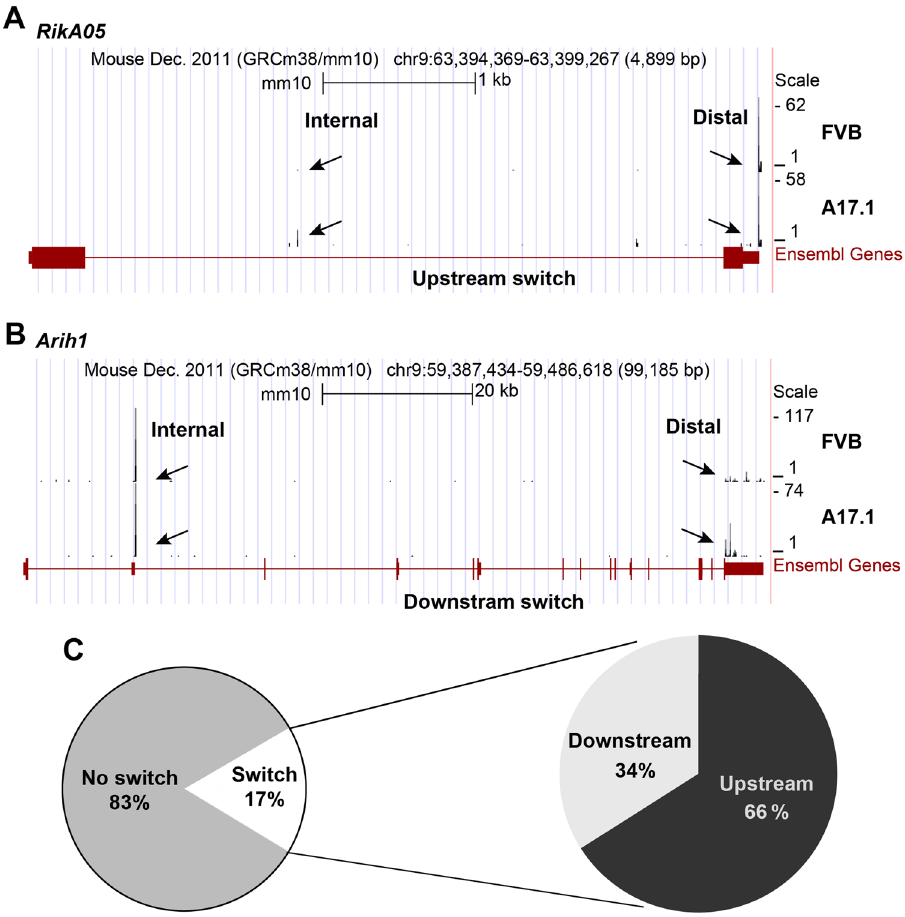
at each PAS. One of the FVB control and A17.1 mice are depicted in independent traces. PASs are depicted by arrows ; distal or internal PASs are indicated. The gene structure based on Ensembl annotation is presented in red . The ampli fi ed regions that were used for validation are indicated below the gene structure; c Pie chart on left side shows the percentage of genes with changes in PAS utilization region (567 genes) and the right pie chart shows the percentage of genes with downstream or upstream switches in PAS utilization (193 and 374 genes,